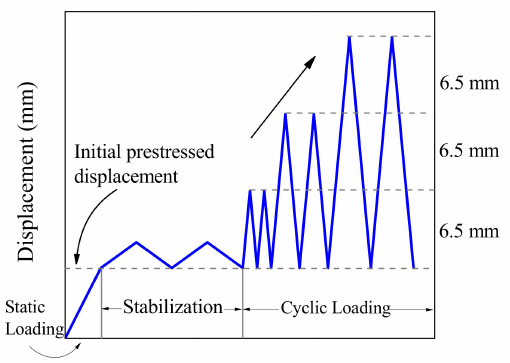
Figure 8. Cyclic protocol for the BFRP tendons with bonded